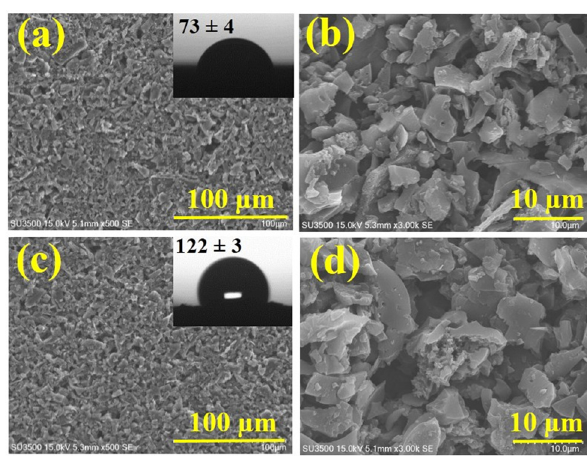
Figure 3: SEM images of ( a and b ) mAC/Gt/PVA - GA and ( c and d ) mAC/Gt/PVdF. Contact angle of ( a ) mAC/Gt/PVA - GA and ( c )